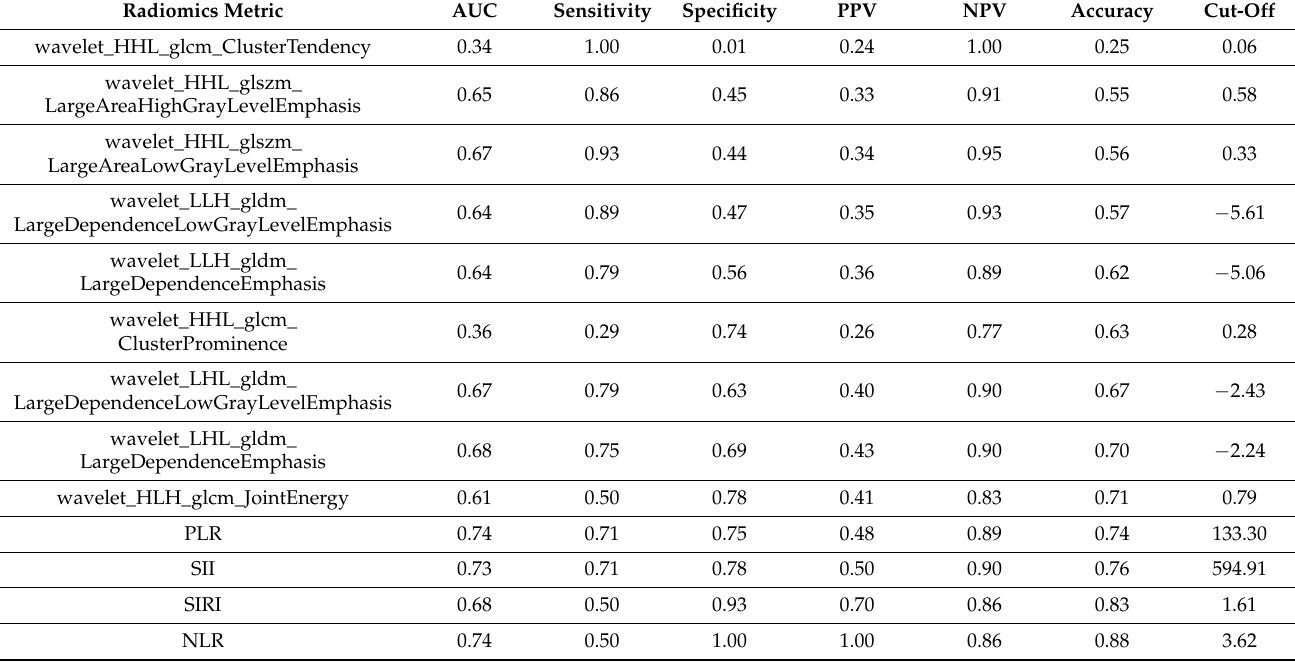
Figure 3. Boxplot of NLR, PLR, SII, and SIRI used to differentiate Warthin tumors from pleomorphic adenoma and malignant carcinoma. The + symbol represents the outliers. When discriminating Warthin tumors from pleomorphic adenoma and malignant SGT, the clinical parameters NLR, PLR, SII, and SIRI showed accuracies of 0.88, 0.74, 0.76, and 0.83, respectively, with appreciable values of the AUC (>0.70, see Table 2). Table 2. Diagnostic performance of clinical and radiomic parameters based on univariate